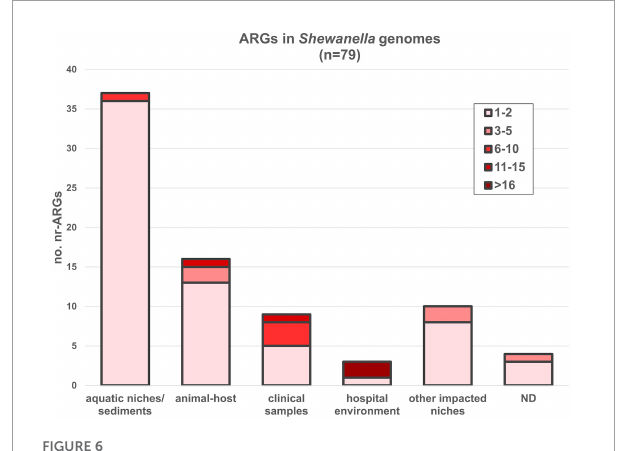
FIGURE6 ARGs found in Shewanella spp. genomes from different niches. AMR genes were depicted according to the source of each strain. nr-ARG represents non-redundant ARM genes in genomes. Colored gradient depicts the range of genes encoded in each genome ( Supplementary Table 13